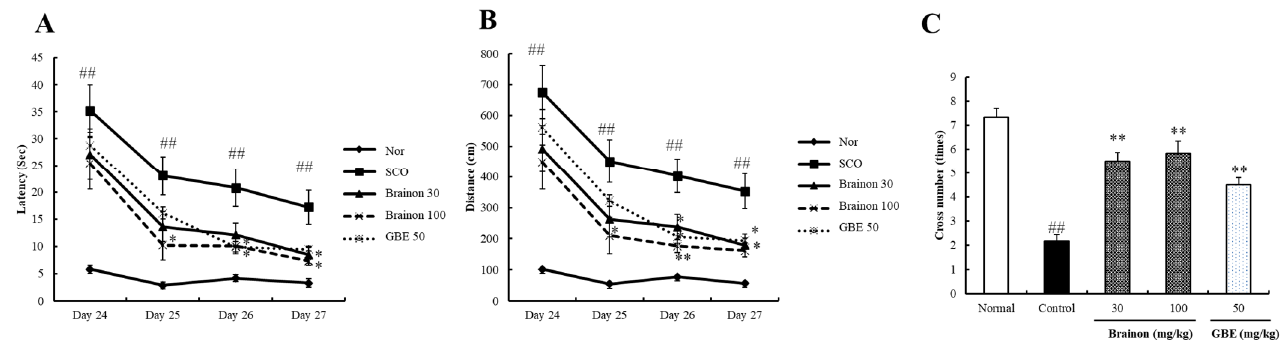
Figure 3. Effects of Brainon scopolamine treated spatial memory deficiency in the MWM trial. ( A ) The escape latency (s) and ( B ) swim distance of mice was investigated for 4 days ( C ) The platform crossing number was carried out on probe trial. Values are represented as means ± SEM ( n = 8). ## p < 0.01 vs. Normal group; * p < 0.05 and ** p < 0.01 vs. SCO-treated group.